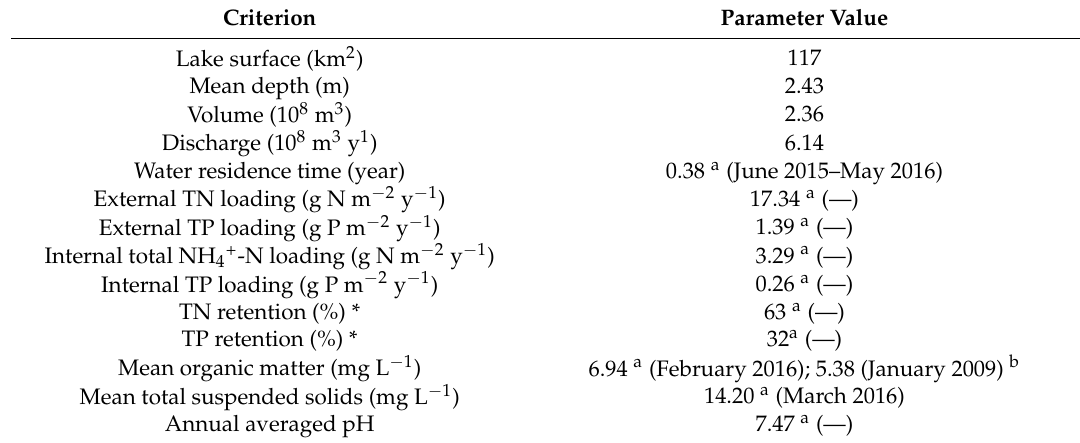
Table 1. The morphological, hydrological, and chemical characteristics of Lake